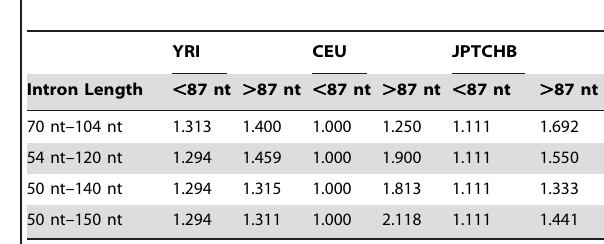
Table 1. RDI (DAF , 0.1) in different intron size intervals from combined datasets of the three populations.